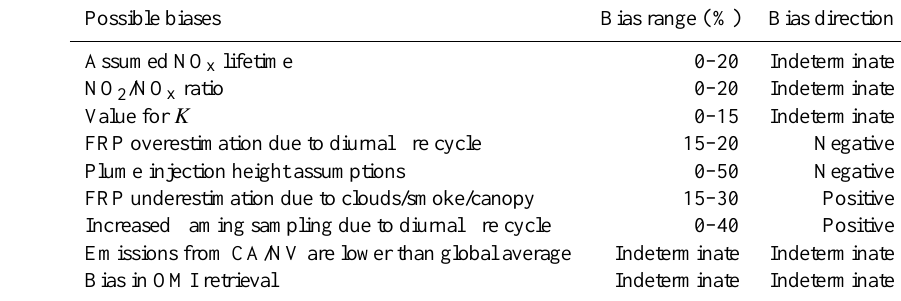
Table 2. Possible biases in this analysis.